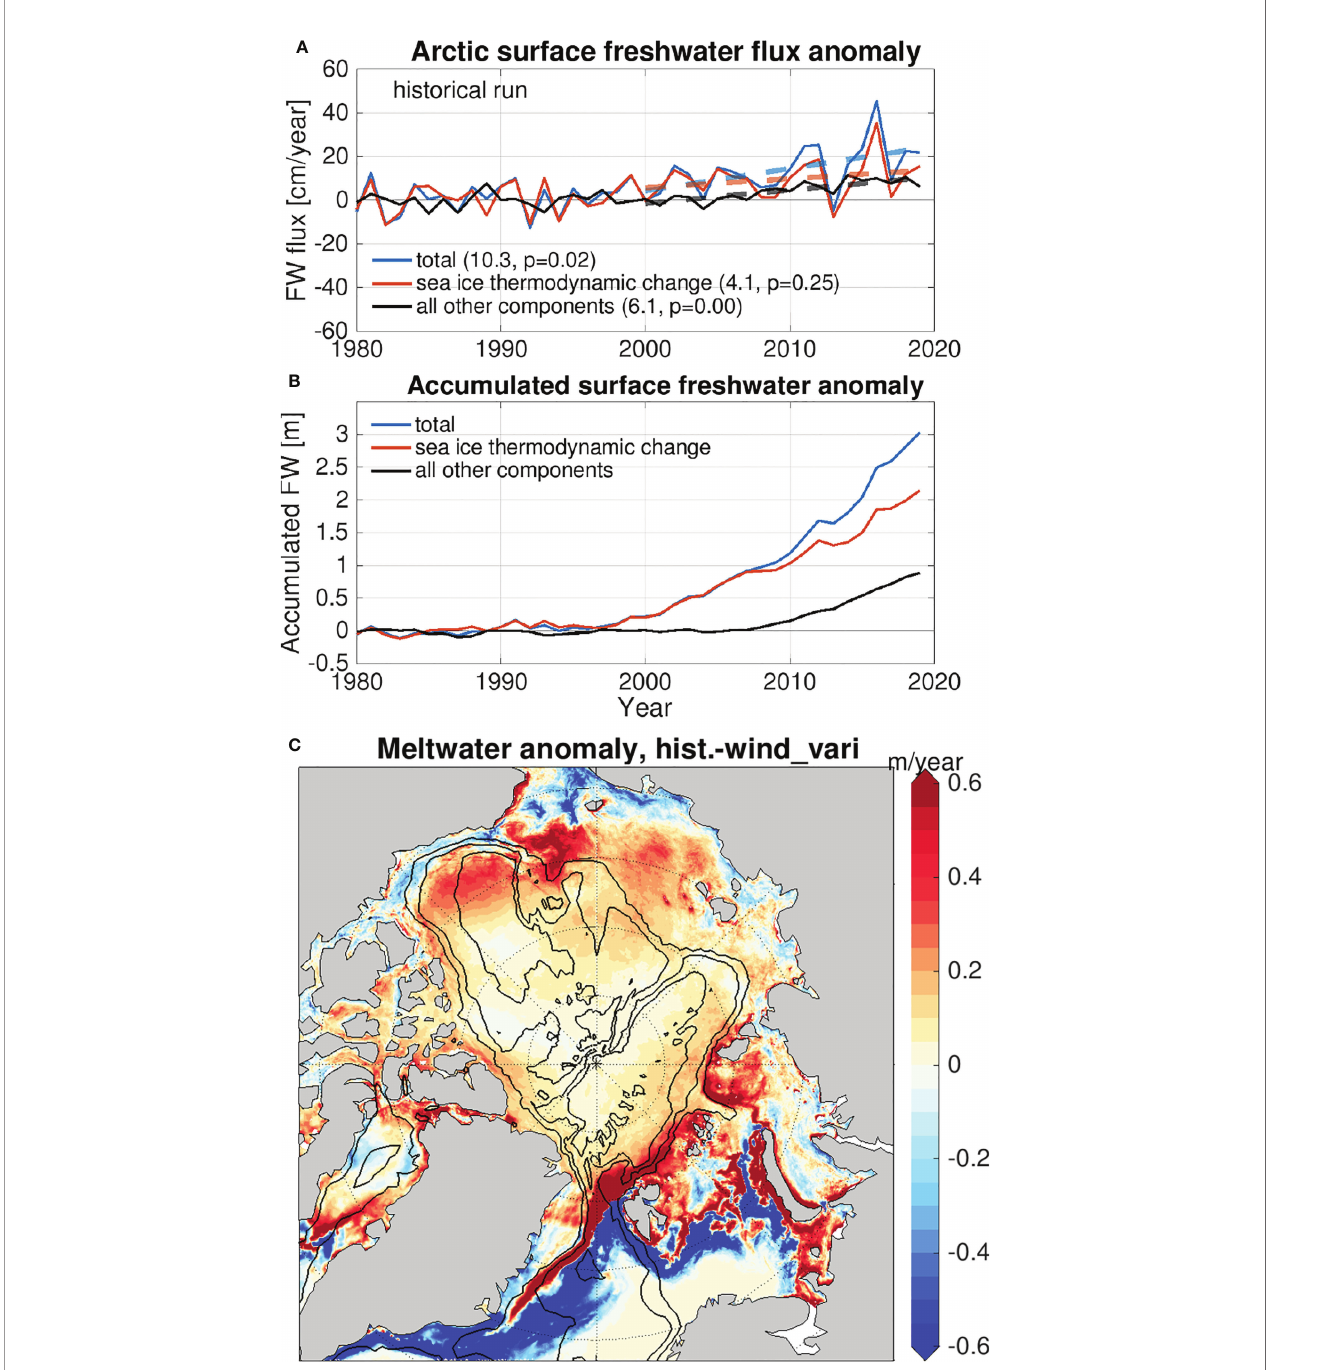
FIGURE 9 | Arctic sea ice decline increases ocean surface freshwater fl ux. (A) Arctic surface freshwater fl ux in the historical simulation: total [blue], the component associated with sea ice thermodynamic growth rate [orange], and the sum of all other components [black]. Their anomalies relative to the 1980s mean are shown. Their trends (cm/year/decade) over the last 20 years are indicated in the legend. (B) The accumulated Arctic surface freshwater anomaly in the historical simulation for different components, that is, the accumulative sum of the time series shown in (A) . Integrated over the last 20 years, sea ice meltwater accounts for about 70% of the total anomalous surface freshwater. (C) Difference of ocean surface freshwater fl ux between the historical simulation and wind_vari simulation averaged over 2001 – 2019, which is mainly due to the difference in sea ice thermodynamic growth rate. Positive values denote freshwater source for the